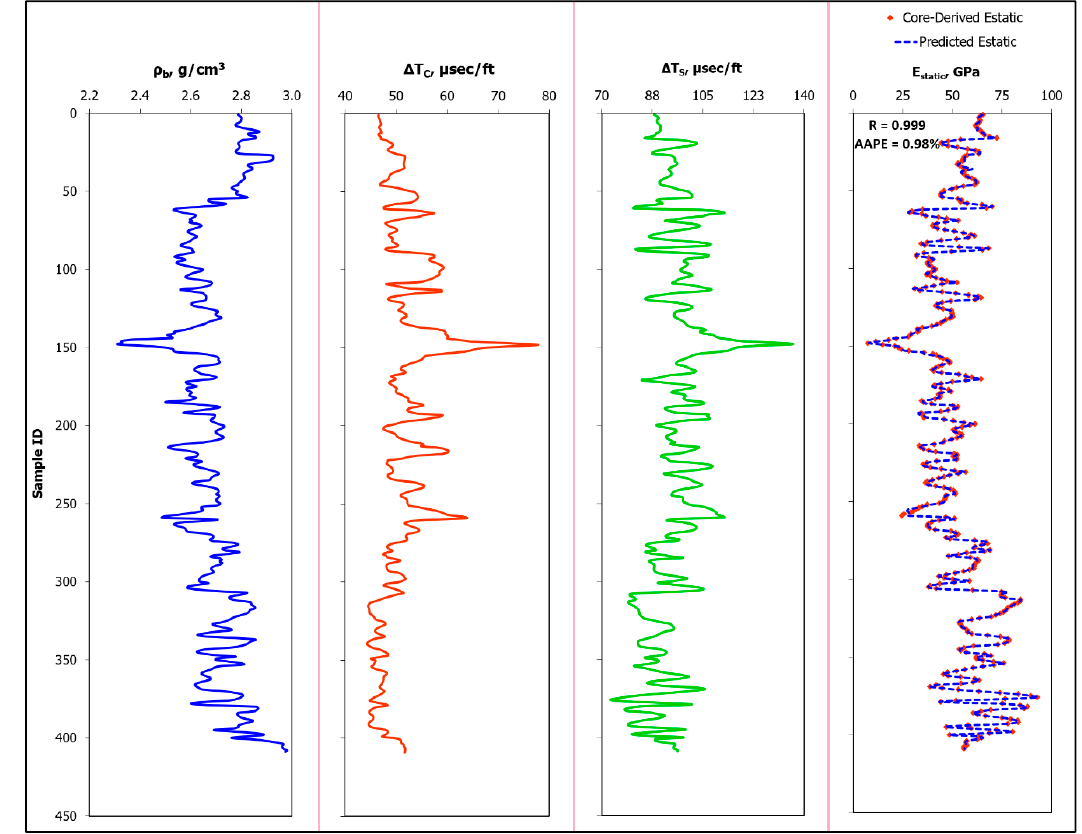
Figure 3. From left to right, bulk density, compressional transit time, shear transit time, and their corresponding predicted and core-derived static Young’s modulus values of the training set of Well-A.